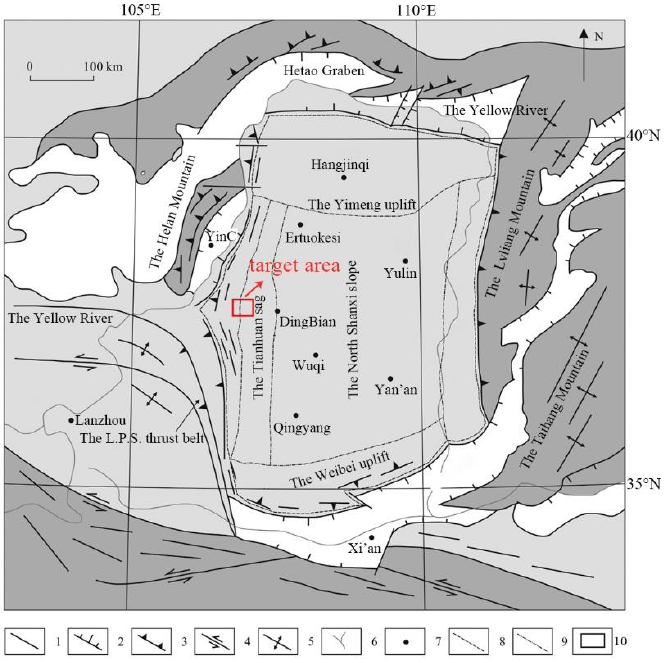
Figure 2. Tectonic framework and units of the Ordos basin (modified according to reference [47]). The white area represents the young graben system around basin margins, and dark gray rep- resents the deformation belts around the Ordos basin. 1 — fault; 2 — normal fault; 3 — thrust fault; 4 — strike-slip fault; 5 — fold; 6 — river; 7 — city; 8 — basin boundary; 9 — tectonic unit boundary; 10 — study area. Figure 3. Target horizon map ranging from 1511ms to 1621ms (zoomed-in version of study area contained within the red frame in Figure 2). w1, w2, and w3 are drilled wells; the red line represents an arbitrary x-line for presentation in Figure 4.